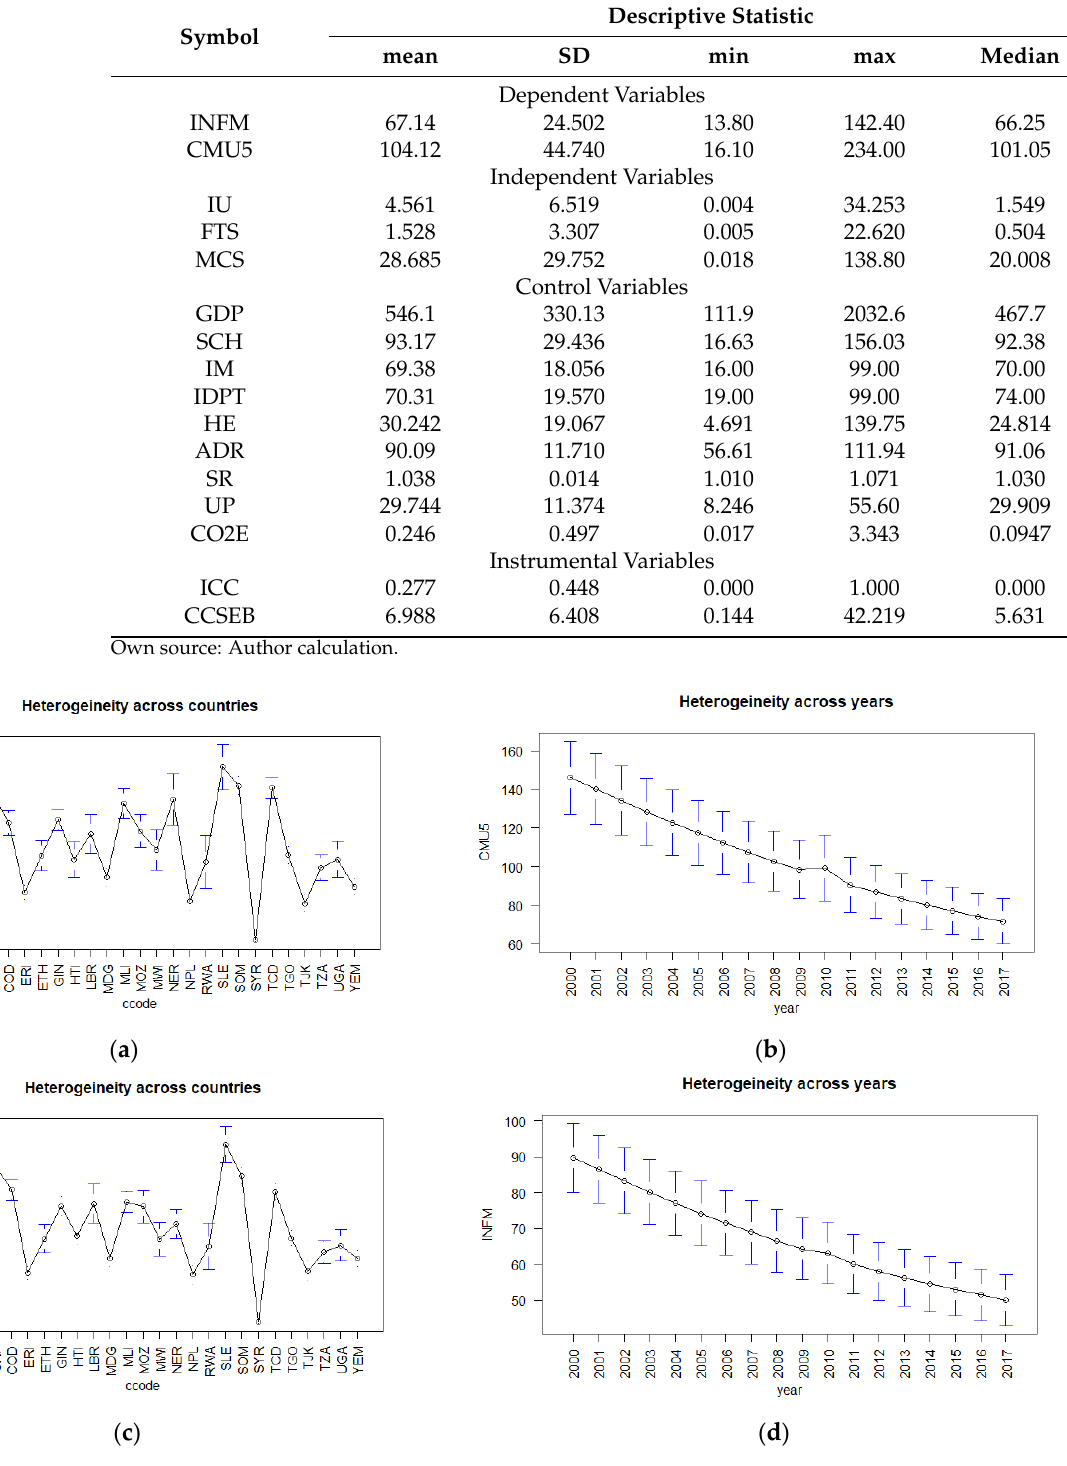
Figure 1. The time and year heterogeneity for the independent variables: CMU5 heterogeneity ( a ) across countries and ( b ) across years; INFM heterogeneity ( c ) across countries and ( d ) across years.